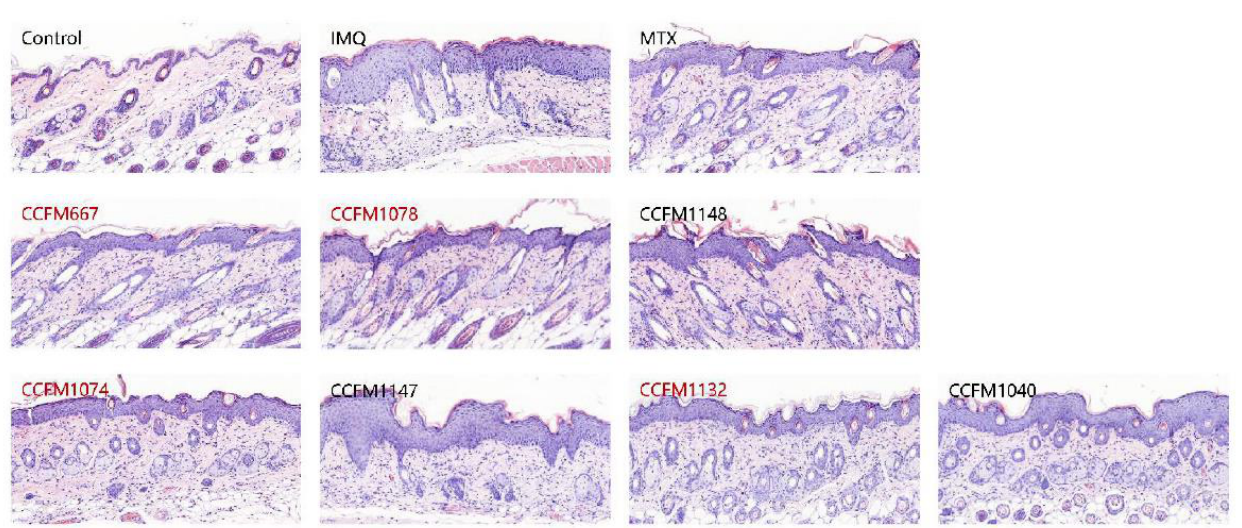
Figure 3. Representative photomicrographs of haematoxylin and eosin sections of dorsal skin tissue.